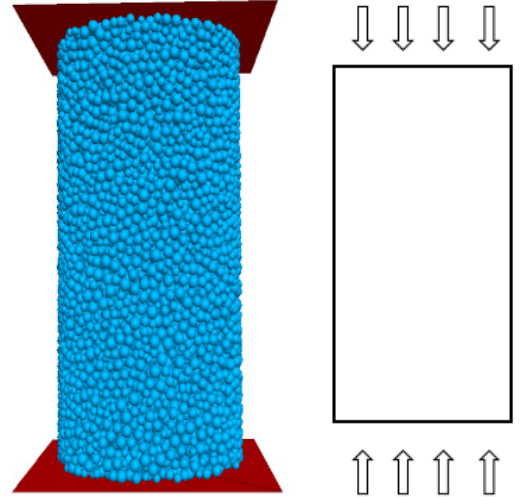
Figure 3. Numerical simulation of uniaxial Figure 4. Triaxial numerical simulation experiment.